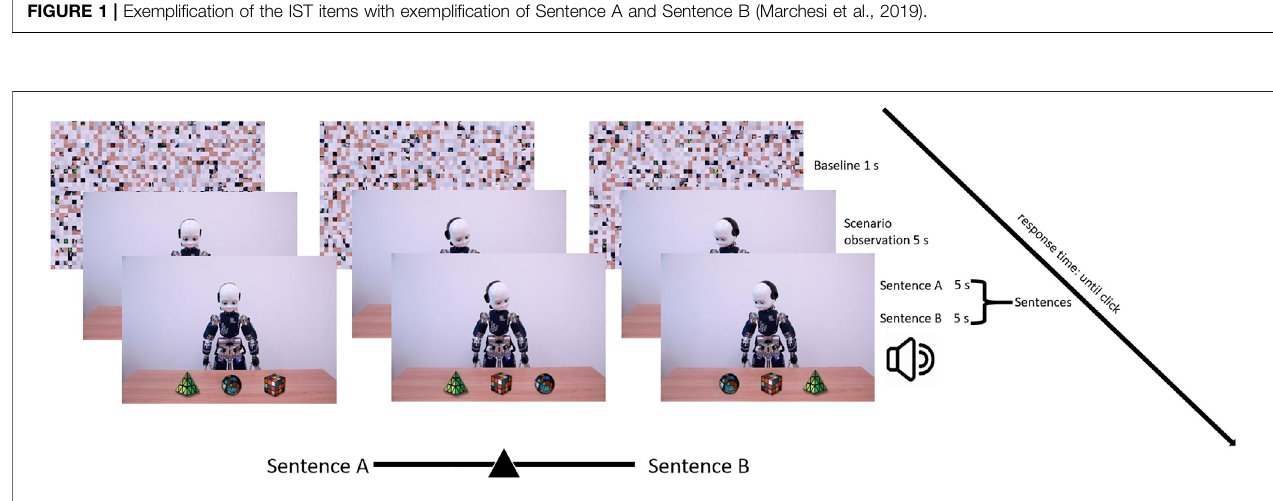
FIGURE 2 | Experimental time